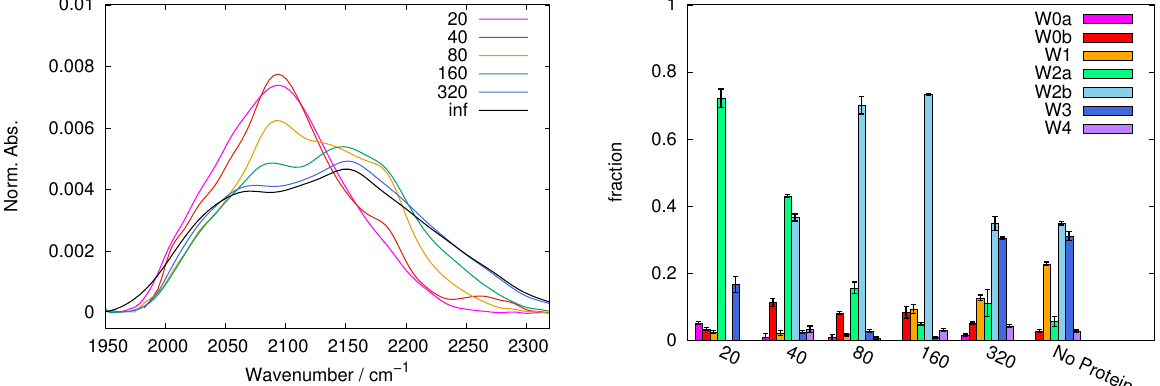
Figure 4. As for Figure 1, in protein + lactose matrices. Here the WAB has a peculiar behaviour with the sugar/protein ratio. The low frequency sub-band in the range 2080–2120 cm − 1 (W2a) immediately gives way to the sub-band W2b (see the transition between S/P = 40 and 80), and then progressively to the high frequency components.